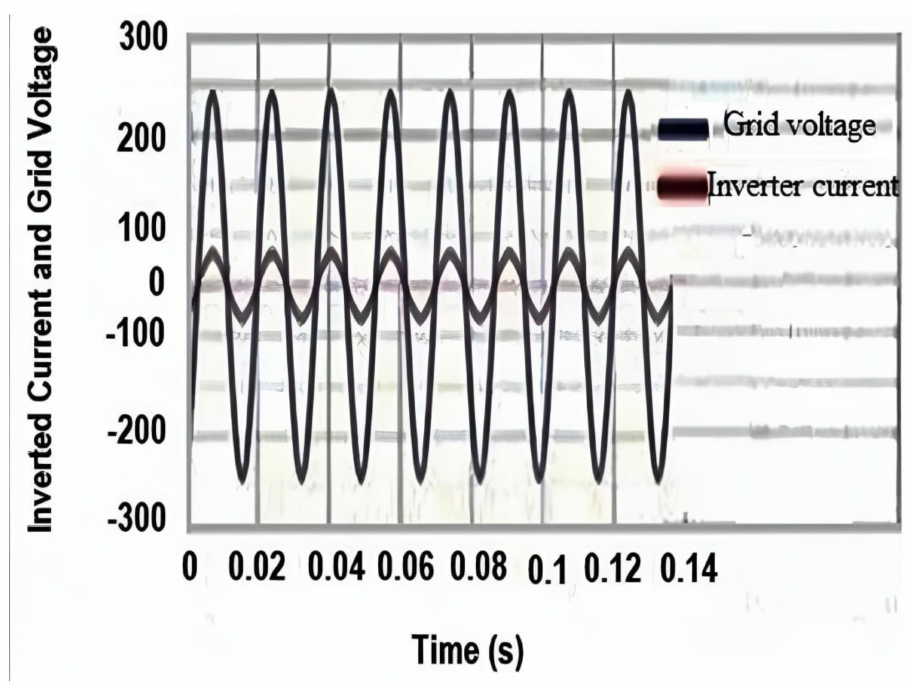
Figure 8. Voltage and current of phase are the unity power factor. This kind of simulation is called low load simulation. It means that the grid and three-phase current separately, as shown in Figure 9.